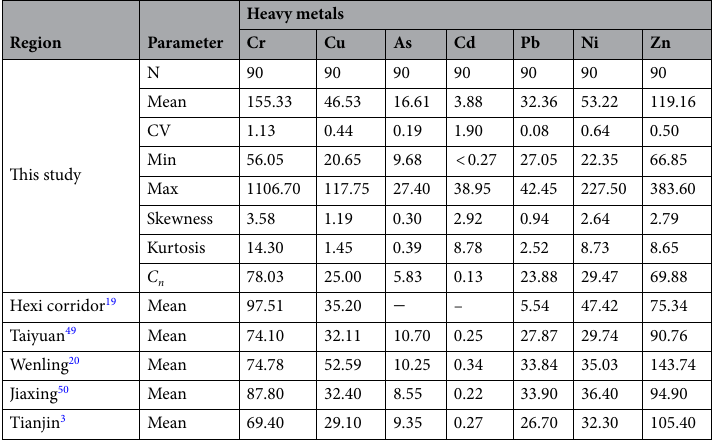
Table 1. Descriptive statistics of HM concentrations (mg/kg) in soils. SD standard deviation, CV coefficient of variance, C n background values of soil HMs in the TGR 40